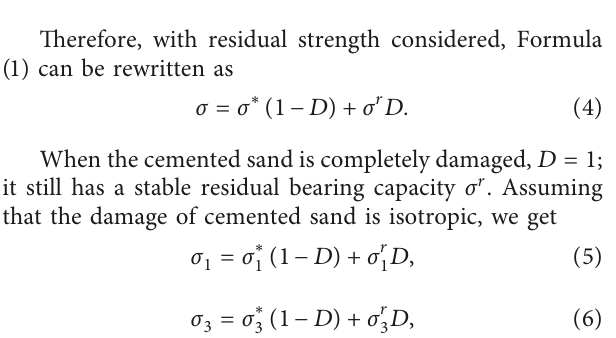
Figure 2: Stress model of cemented sand